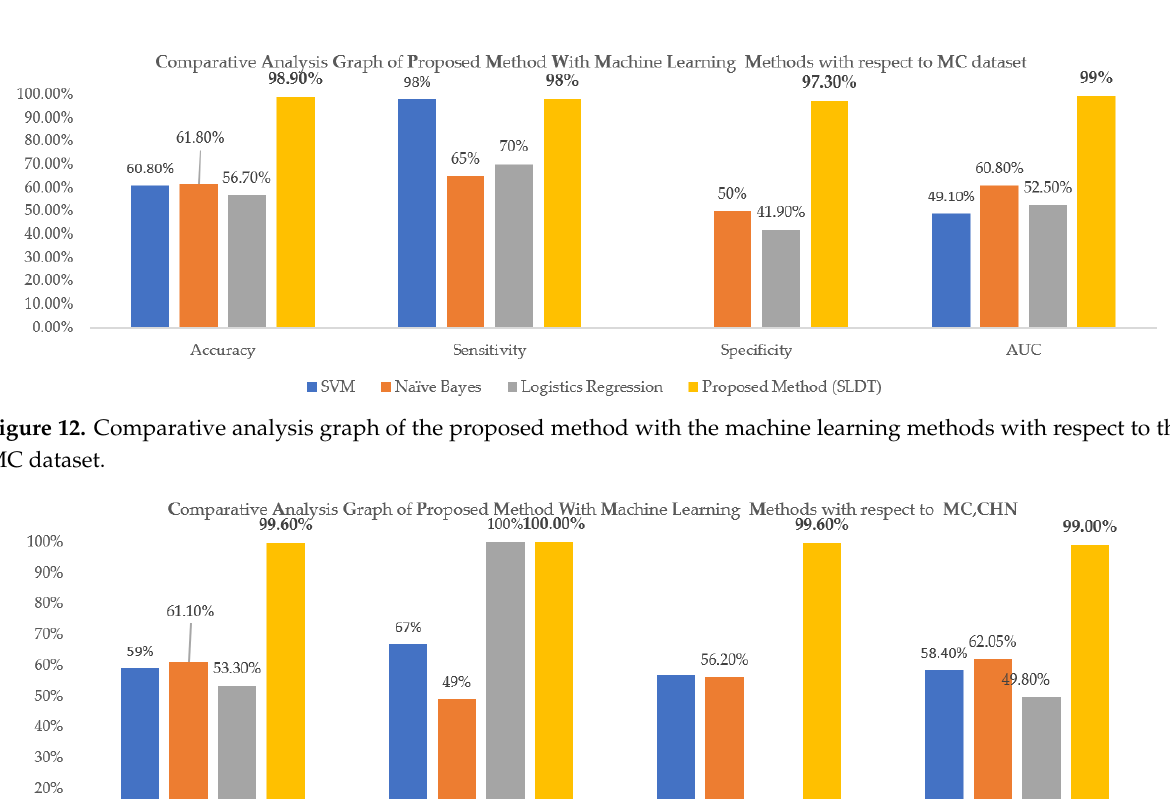
Figure 11. Comparative analysis graph of the proposed method with the machine learning methods with respect to the CHN dataset.